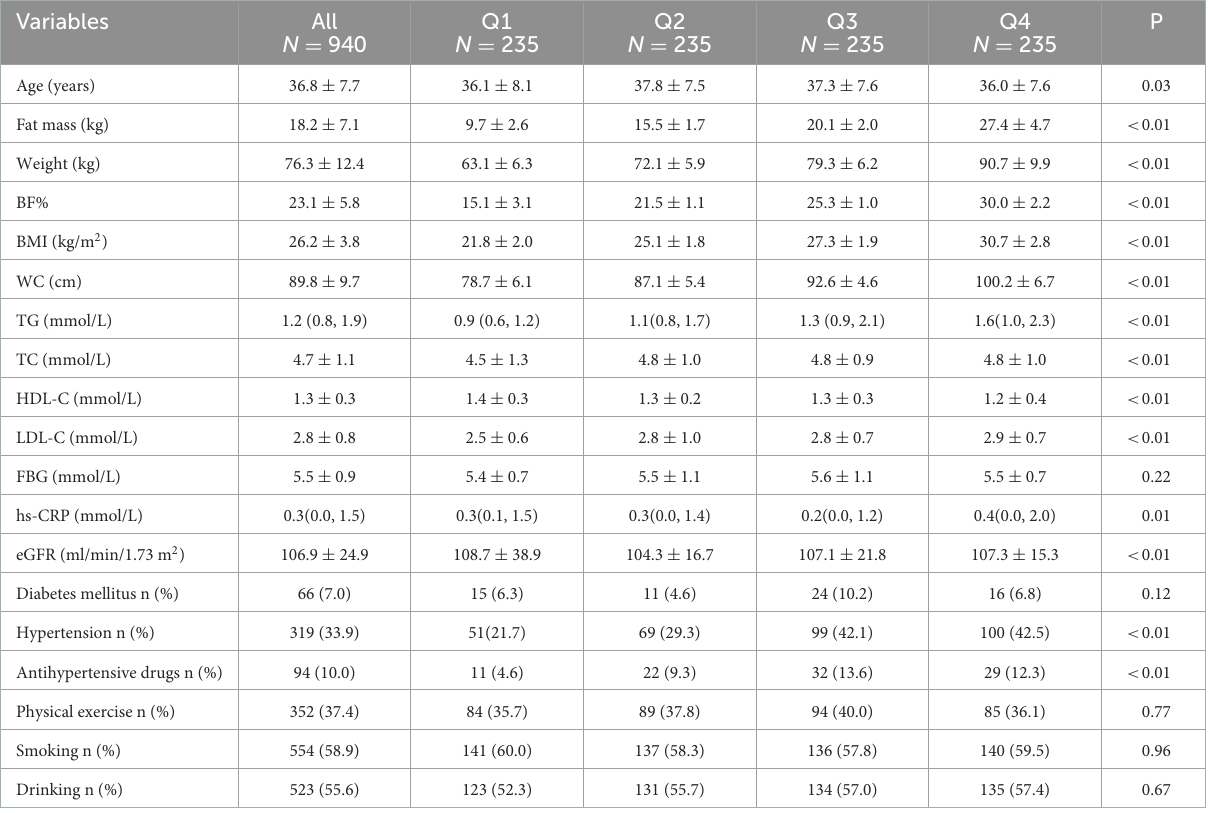
TABLE 1 Baseline characteristics for participants with different